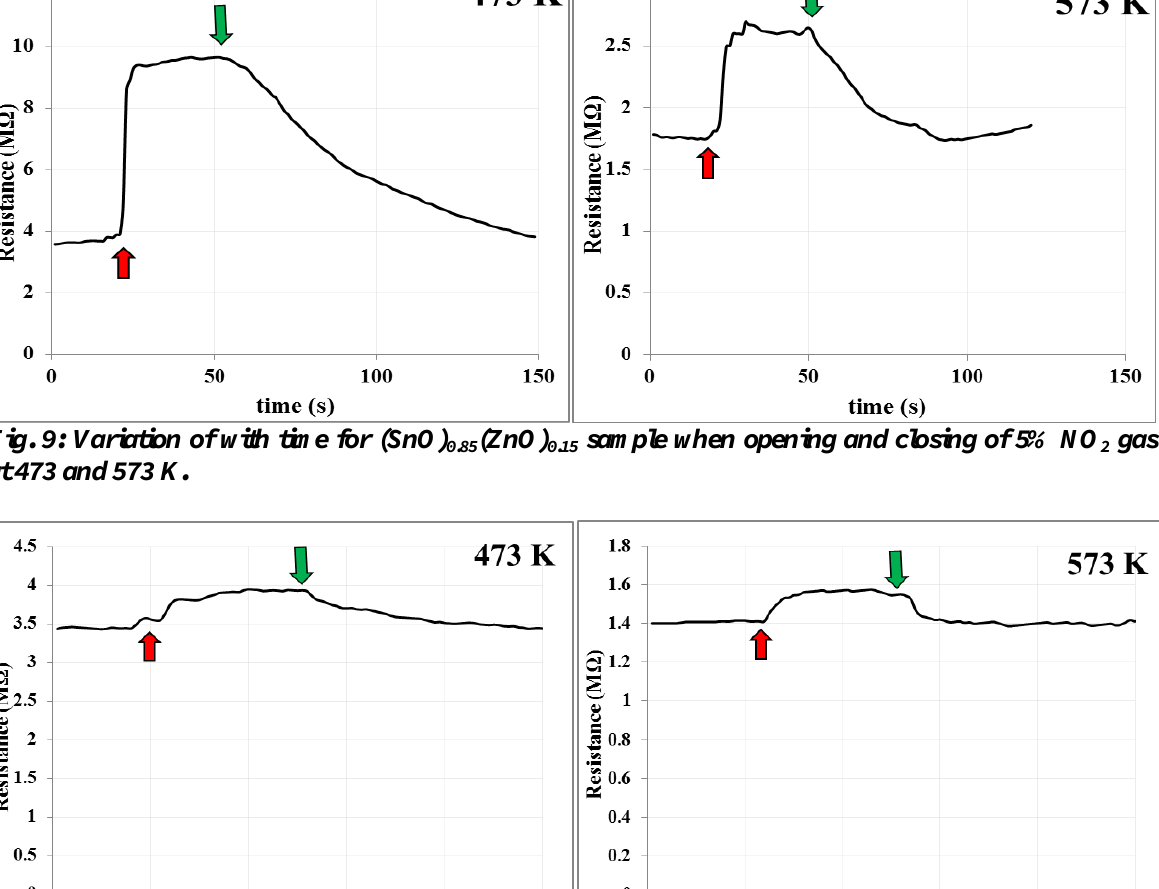
(ZnO) sample when opening and closing of 5% NO 0.8 0.2